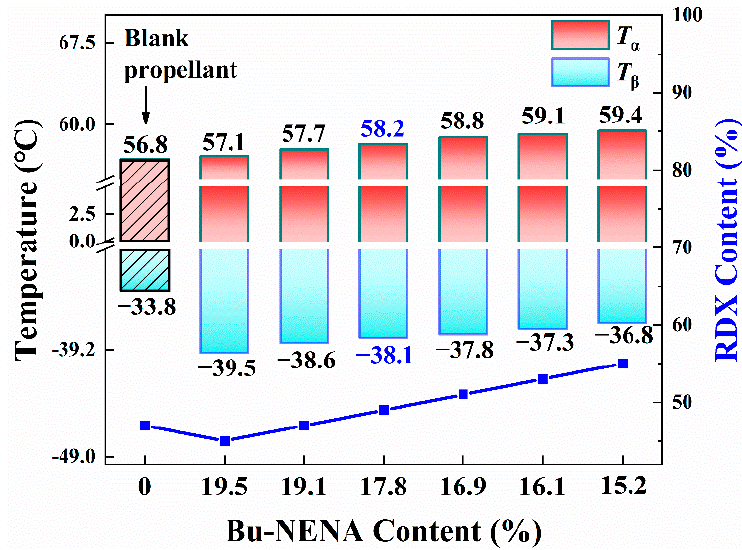
Figure 4. The values of T α and T β of prepared propellants.